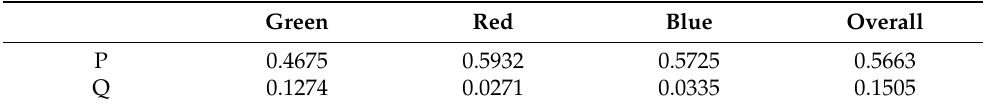
Table 1. Fitting coefficients for different types of point